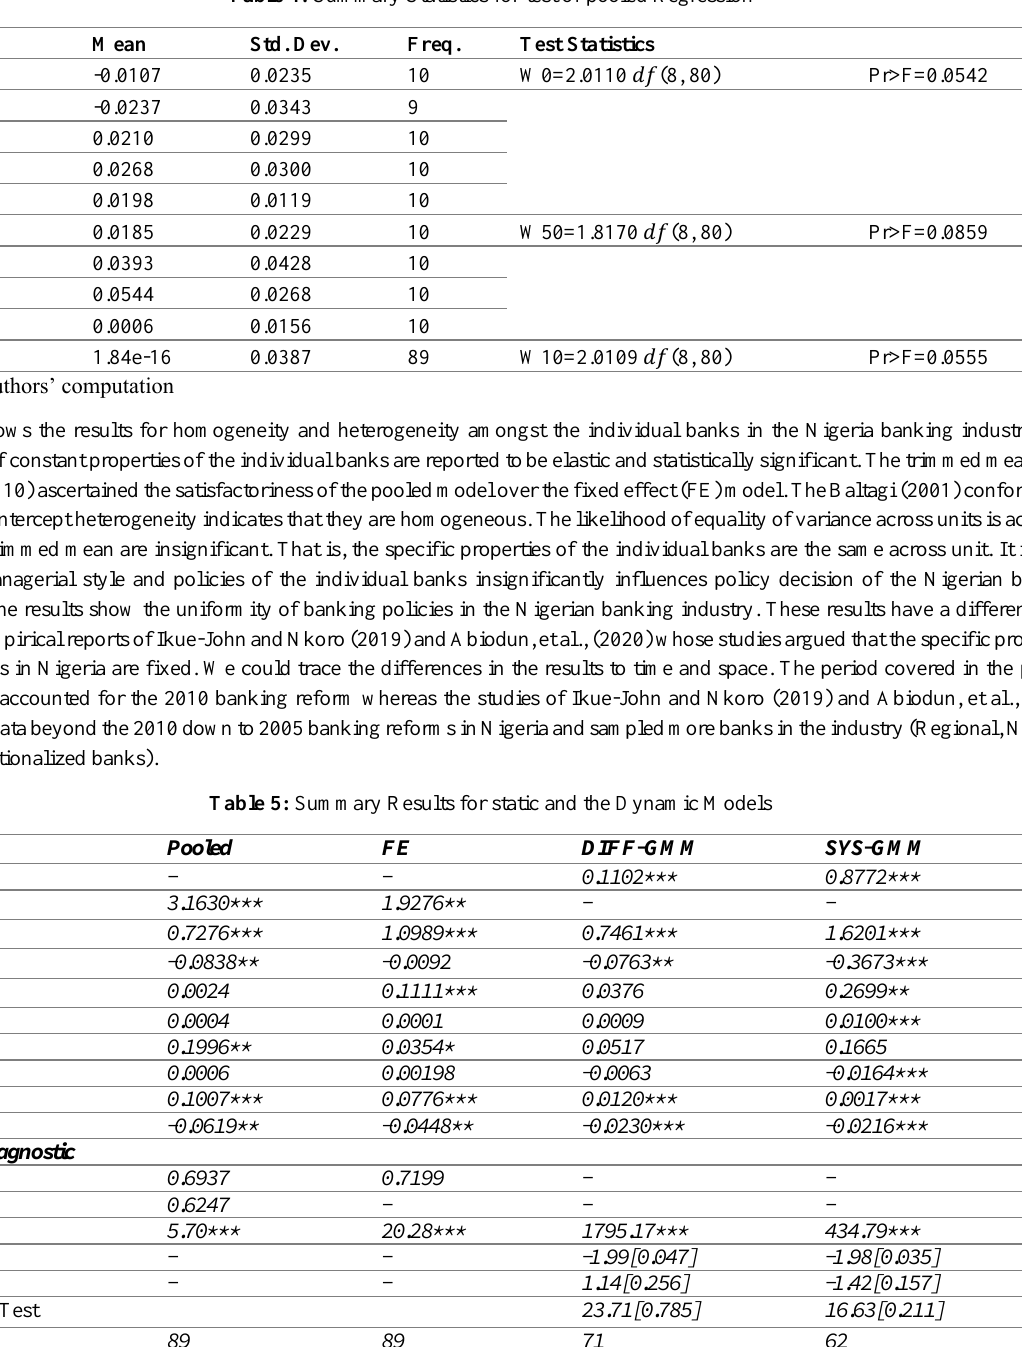
Table 4: Summary Statistics for test of pooled Regression